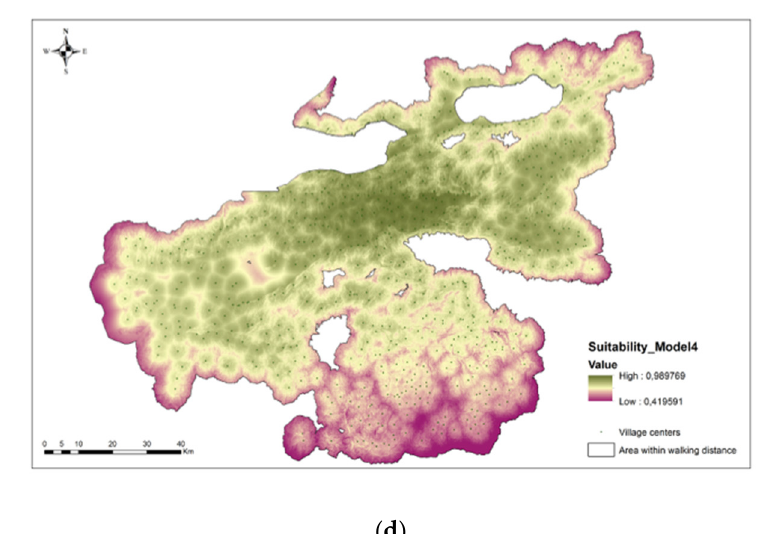
Figure A2. Residential suitability maps for different scenarios ( a ) Model1, ( b ) Model2, ( c ) Model3, ( d ) Model4.